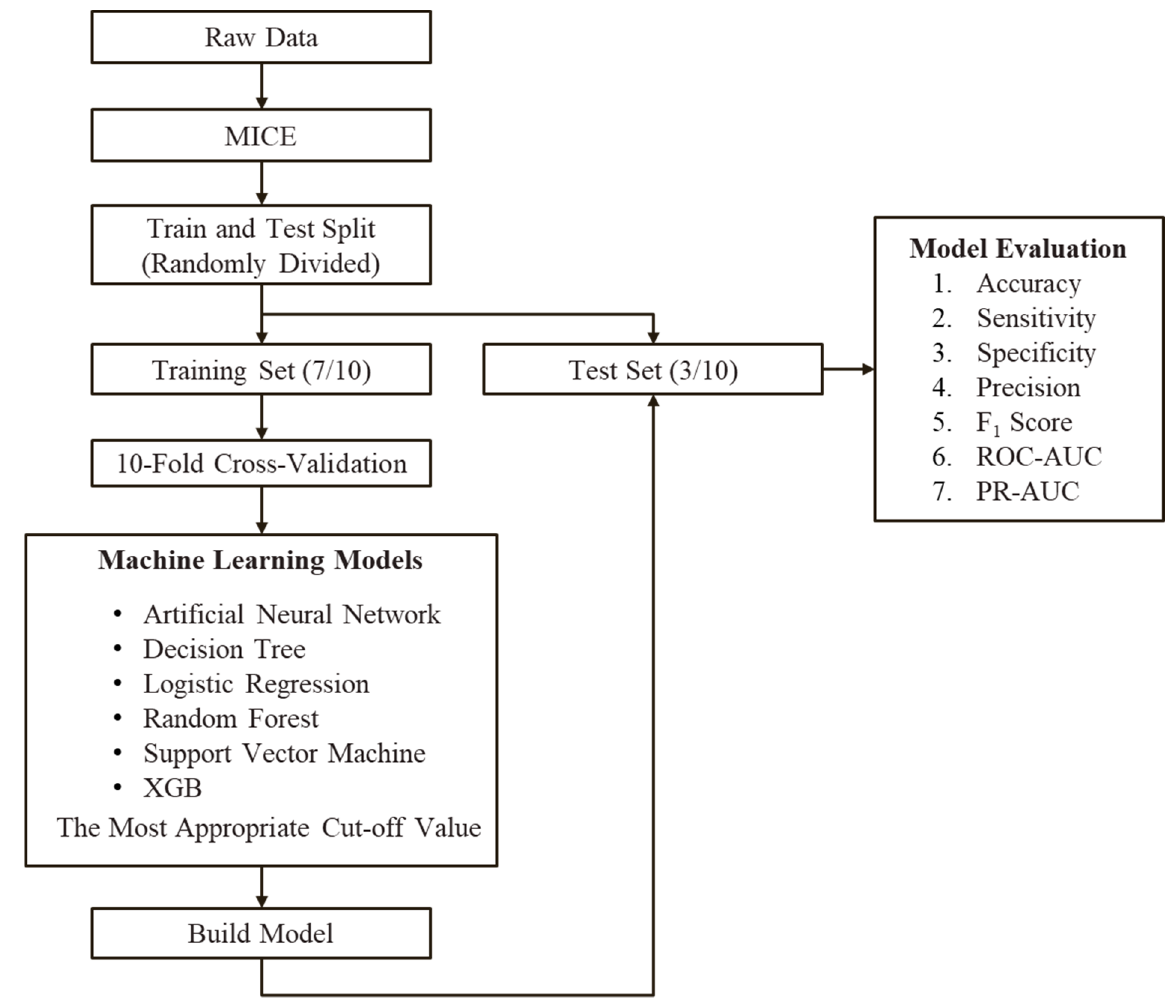
Figure 2. Flowchart of the proposed method.